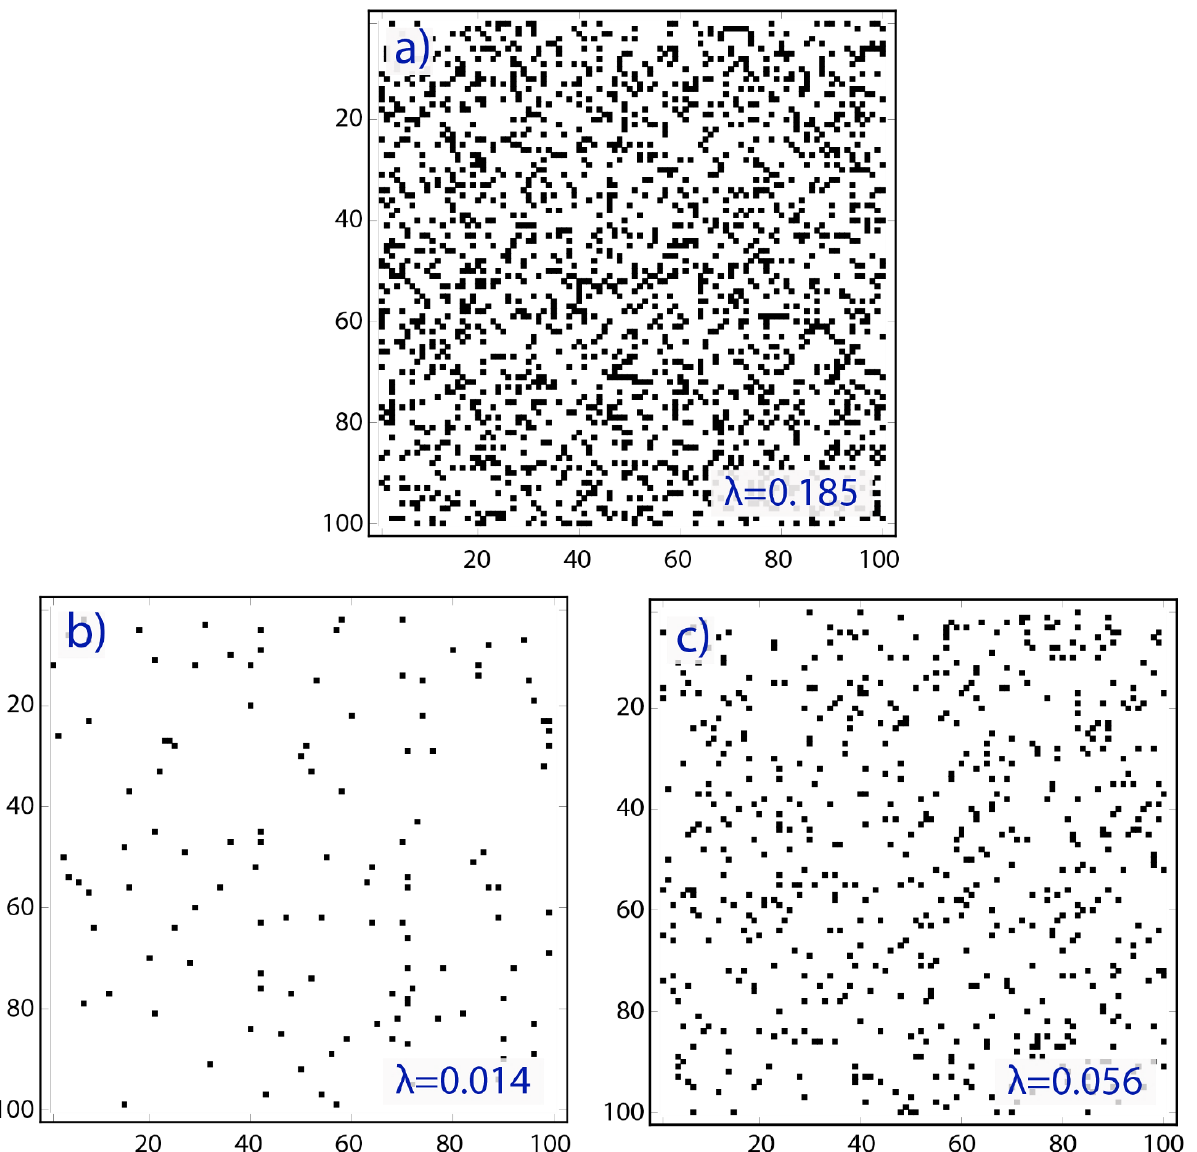
Figure 6. Matrix representation of the growth rate coefficient ( 𝝀 ) from (a) exponential model (for simplicity is taken 𝝀 ), (b) discrete logistic equation, and (c) solved ODE logistic model. Black markers represent the infected people affected by COVID-